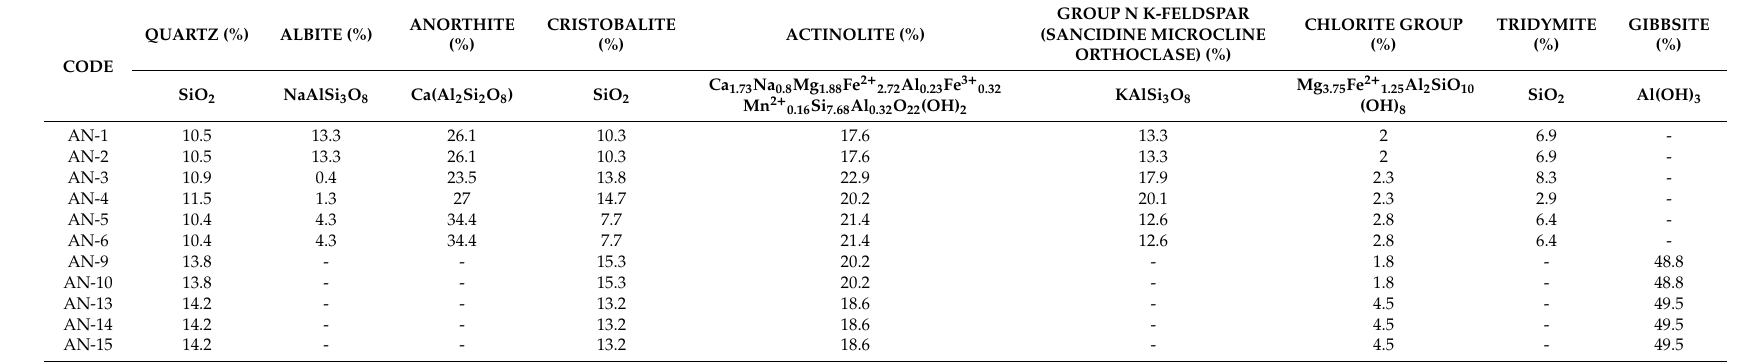
Table 5. Determination of minerals by X-ray di ff raction (XRD) of pure